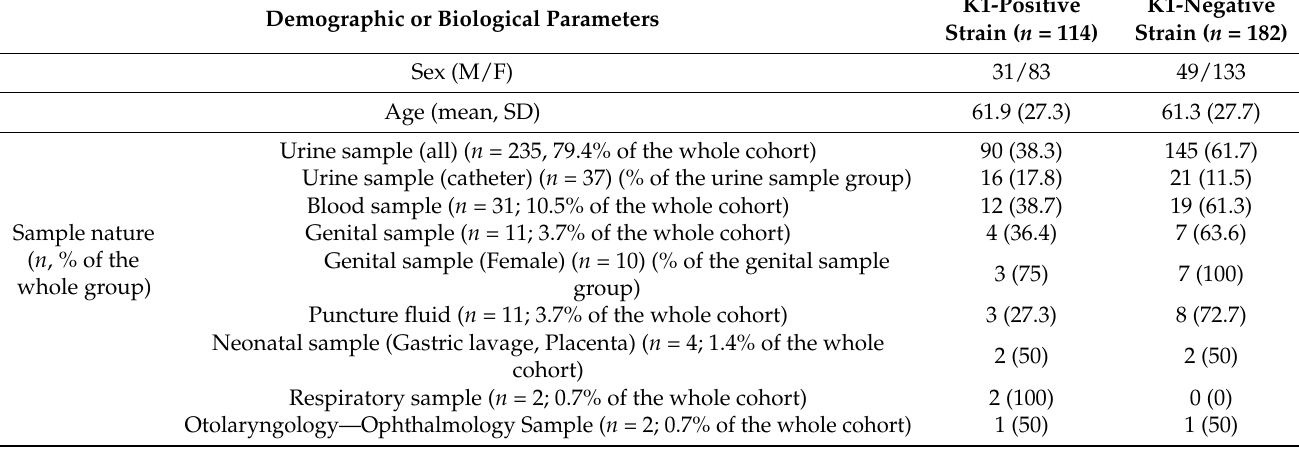
Table 1. Demographic characteristics and sample nature of the analyzed cohort.